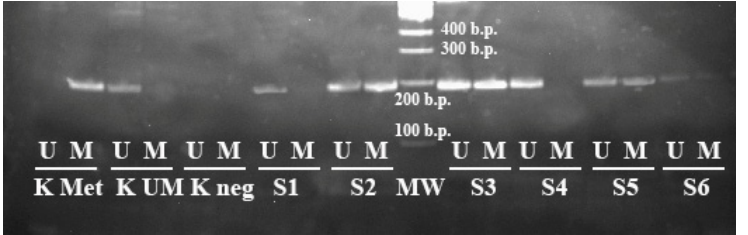
Figure 5. Results of the methyl-specific PCR to determine the methylation status of the MIR-129-2 gene (electrophoresis in 5% polyacrylamide gel, M—PCR with primers specific for the methylated allele, UM—PCR with primers specific for the unmethylated allele). K Met—control methylated DNA, K UM—control unmethylated DNA, K negative—negative control, S1–S6—samples of